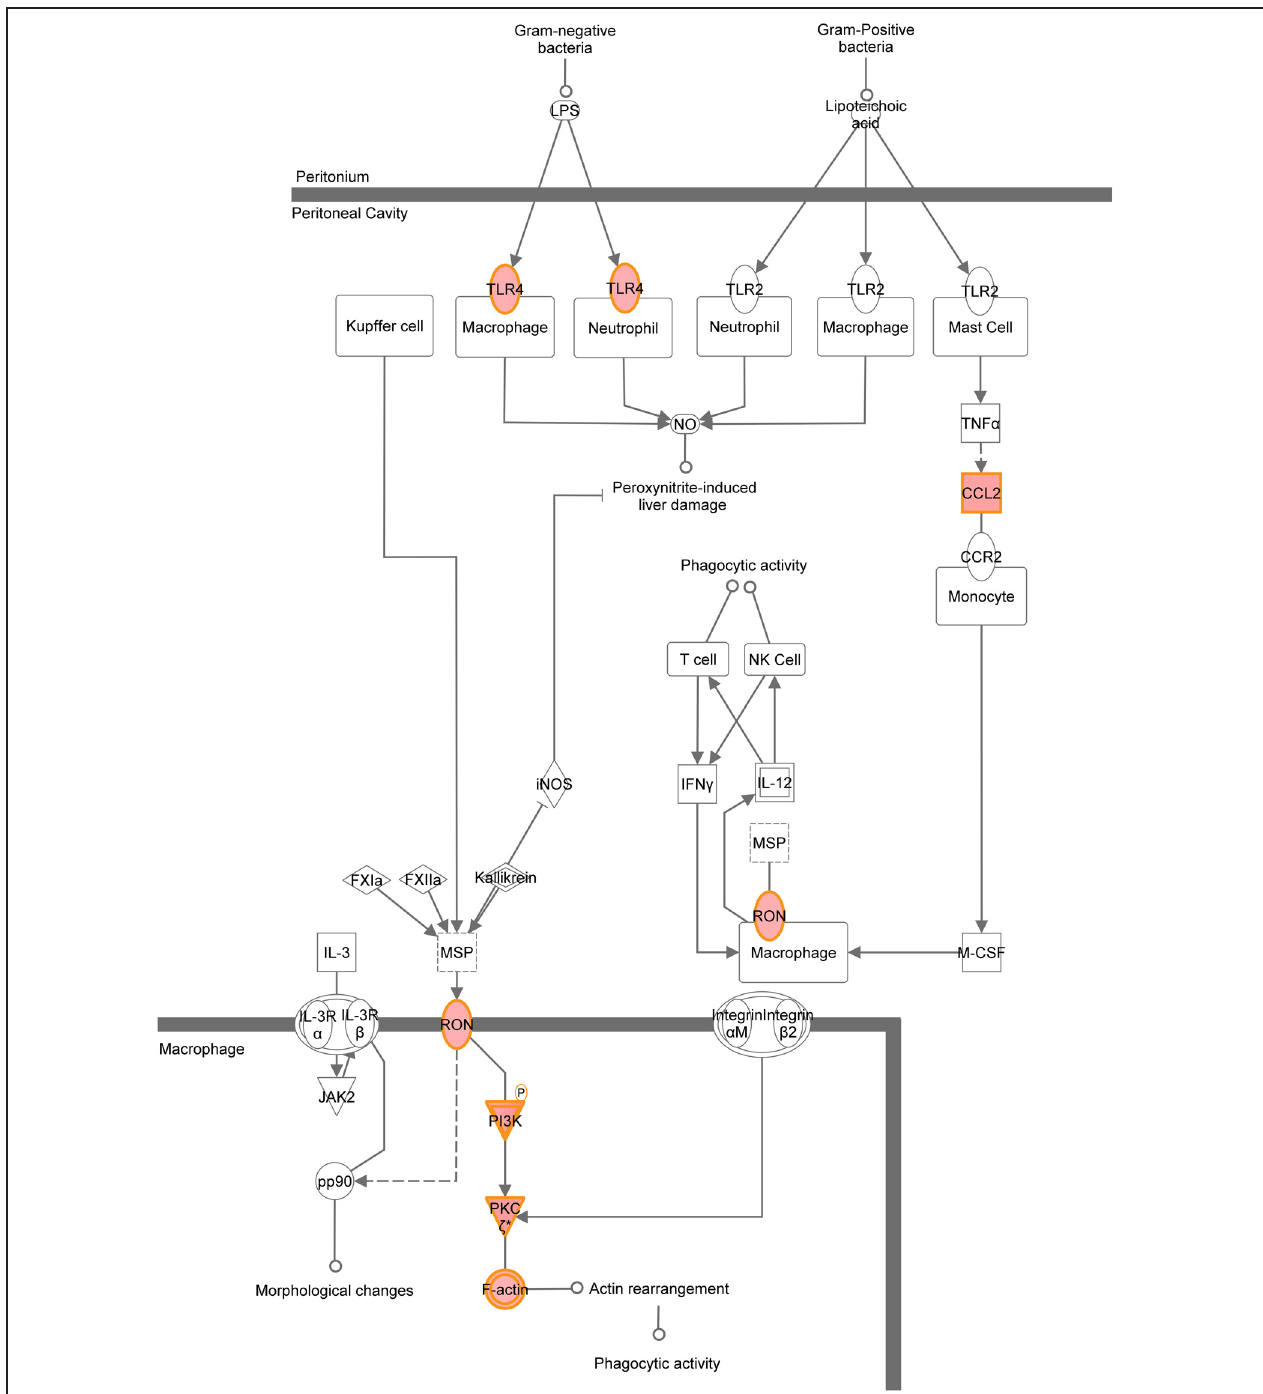
FIGURE A6 | MSP-RON signaling pathway.